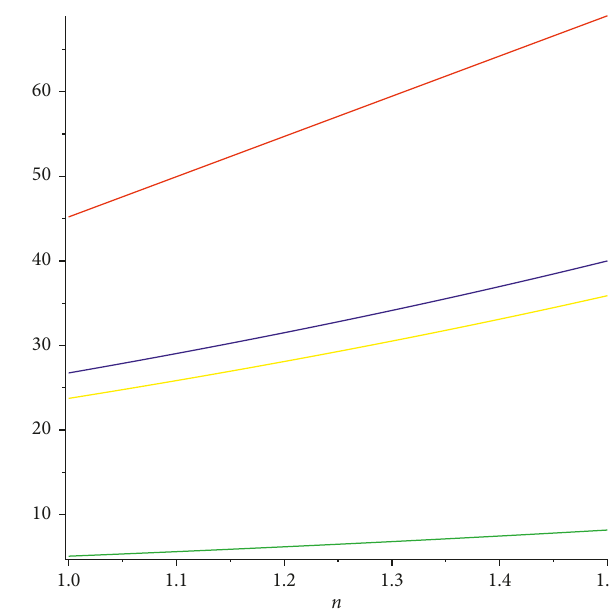
P n n , PETIM, DPZ n , and PETAA.